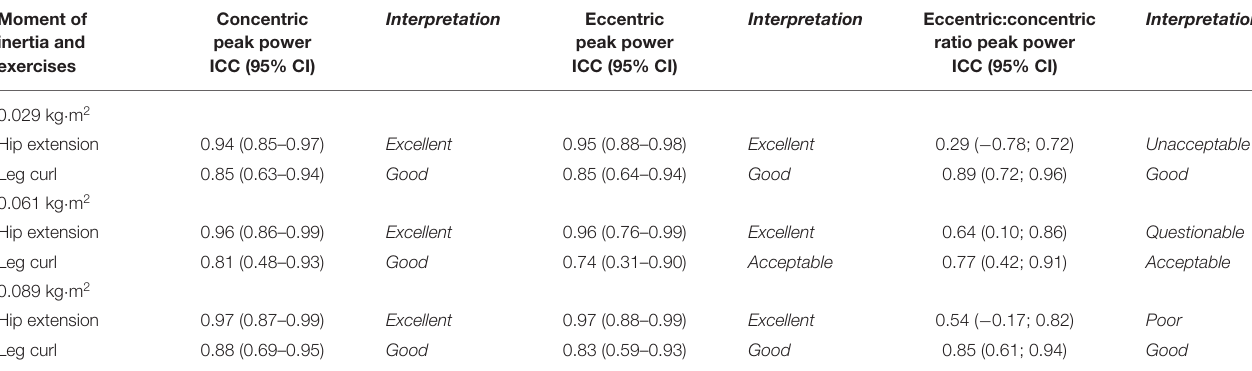
TABLE 2 | Unilateral flywheel leg curl and hip extension between session reliability. Moment of inertia